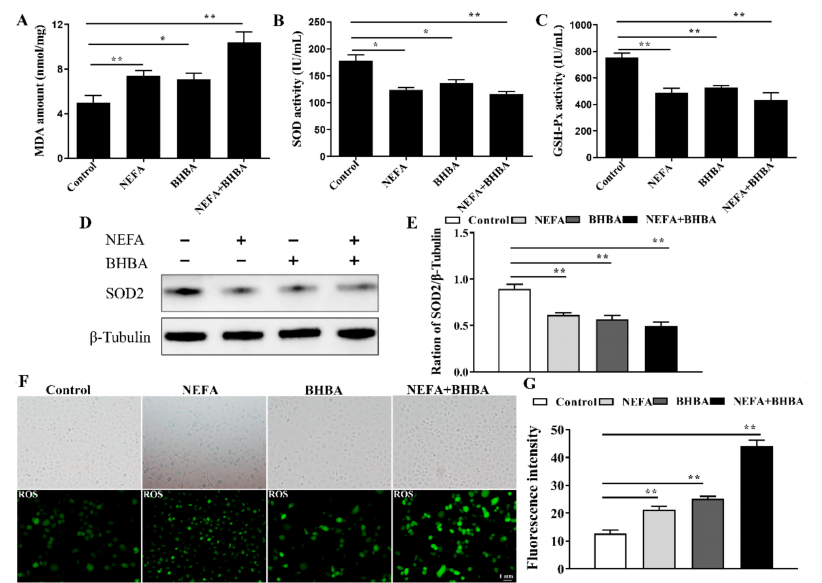
Figure 3. NEFA and BHBA treatment induced oxidative stress in BMECs. ( A – C ) levels of MDA, SOD, and GSH-Px in BMECs treated with NEFA and BHBA. ( D , E ) Protein expression of SOD2 in BMECs treated with NEFA and BHBA. ( F ) ROS levels in BMECs treated with NEFA and BHBA. ( G ) Green fluorescence intensity of NO was quantified by Image J. Data are presented as the means ± SEM of three independent experiments. * p < 0.05; ** p < 0.01.